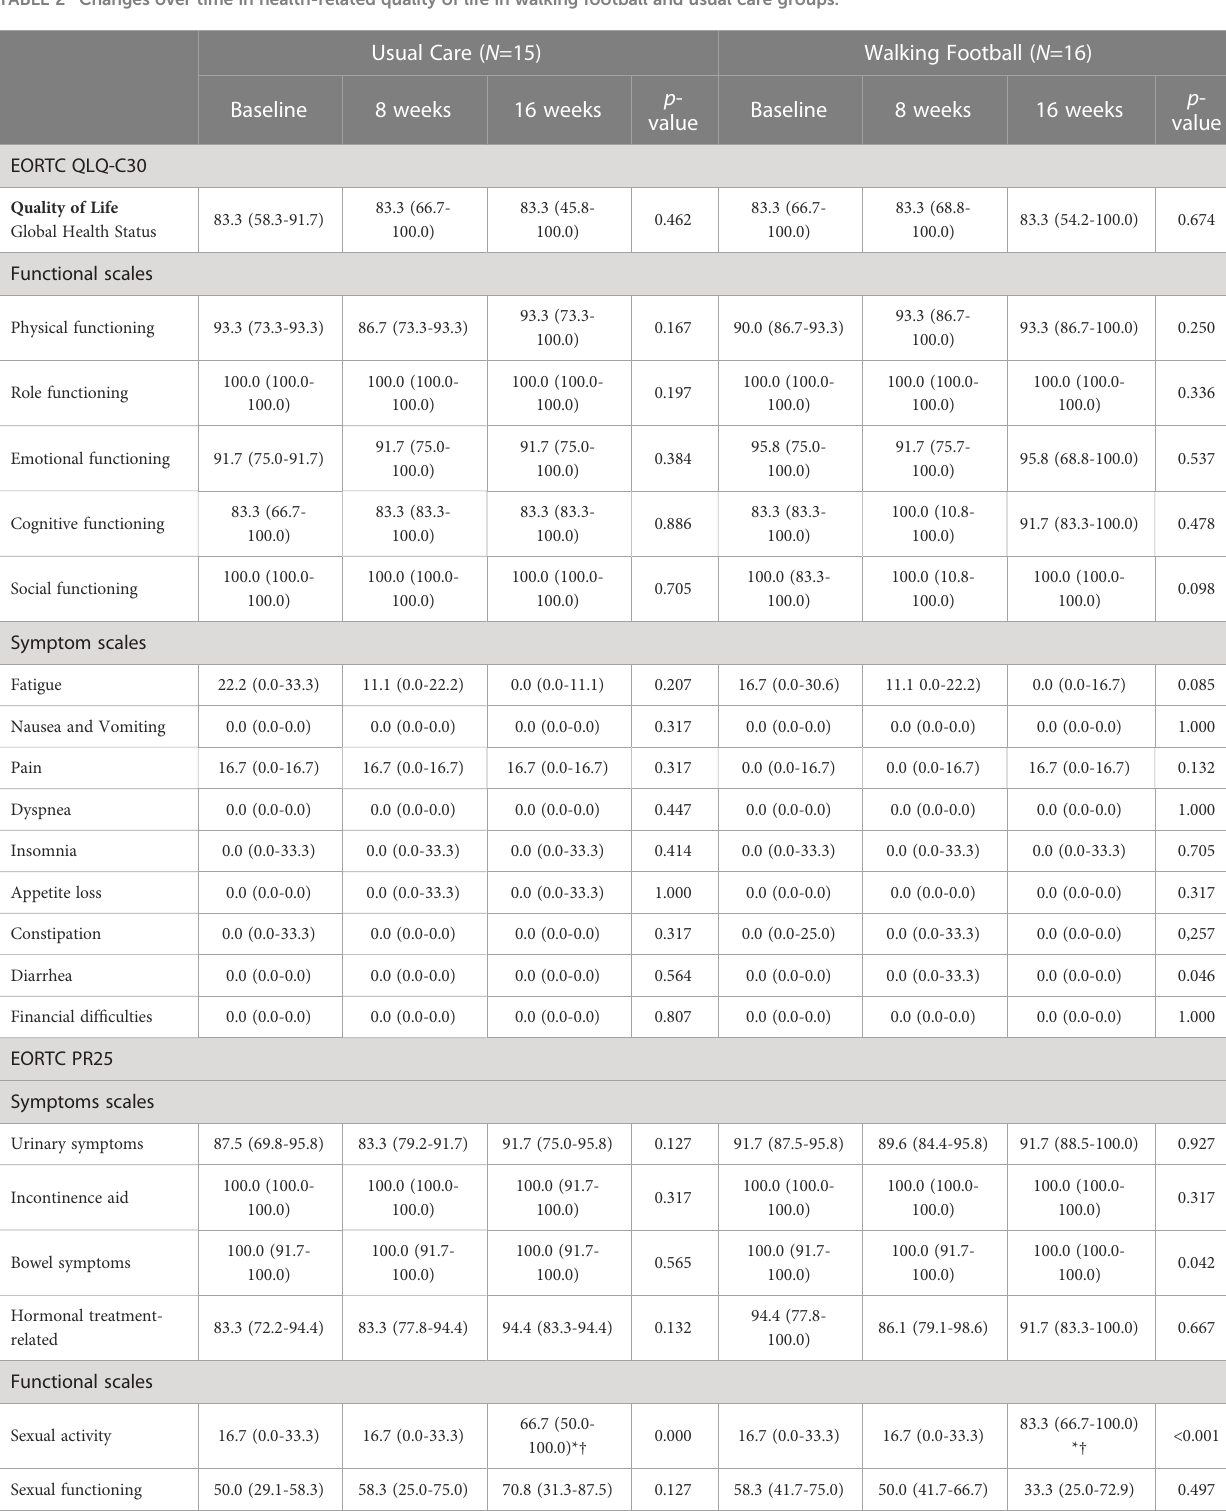
TABLE 2 Changes over time in health-related quality of life in walking football and usual care